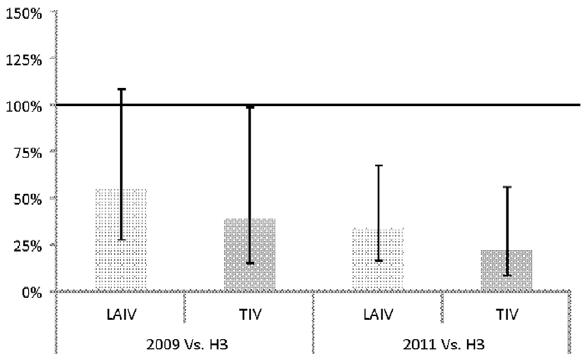
Figure 2. Estimate of odds of a 4-fold conversion relative to conversions against the H3N2